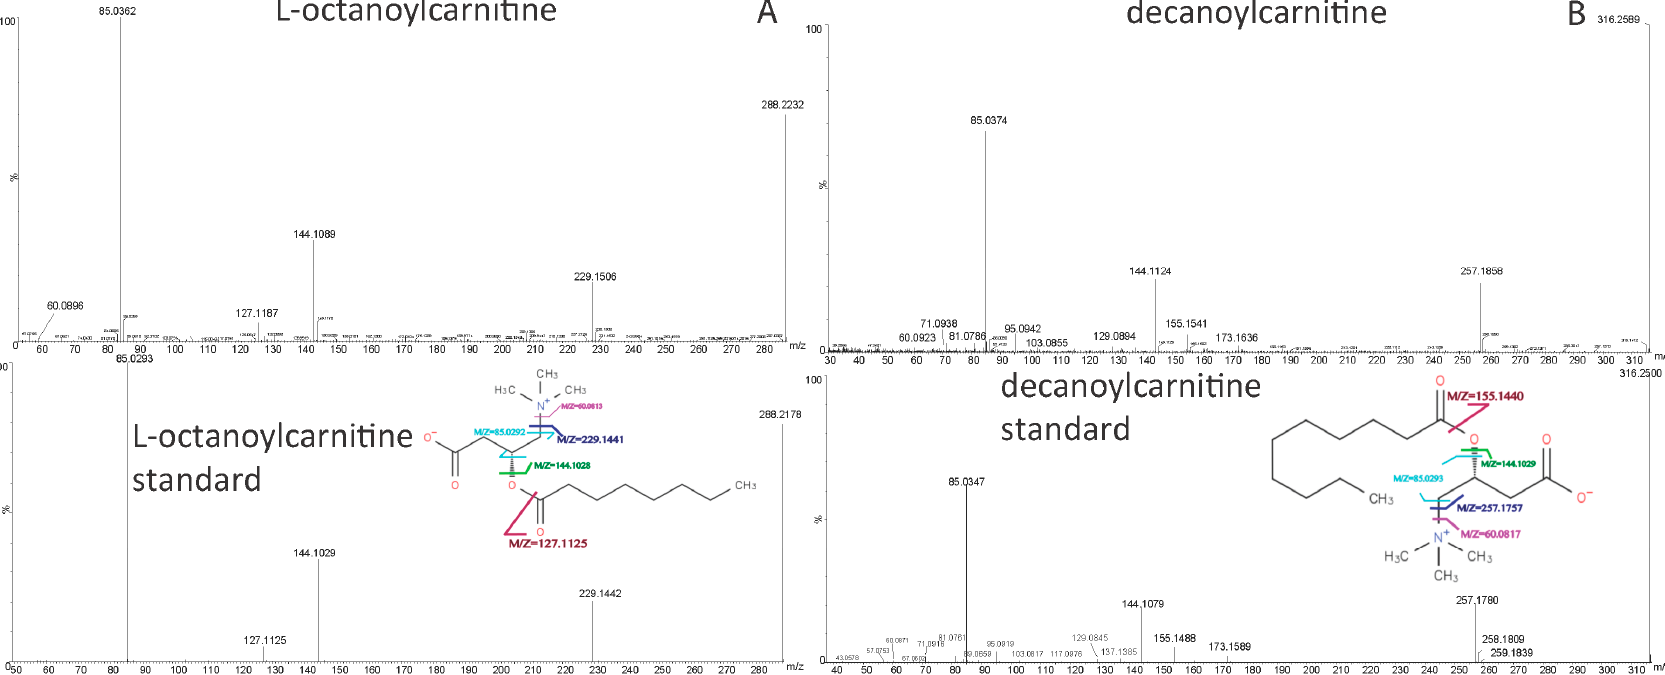
Figure 3. Cont. Figure 3.